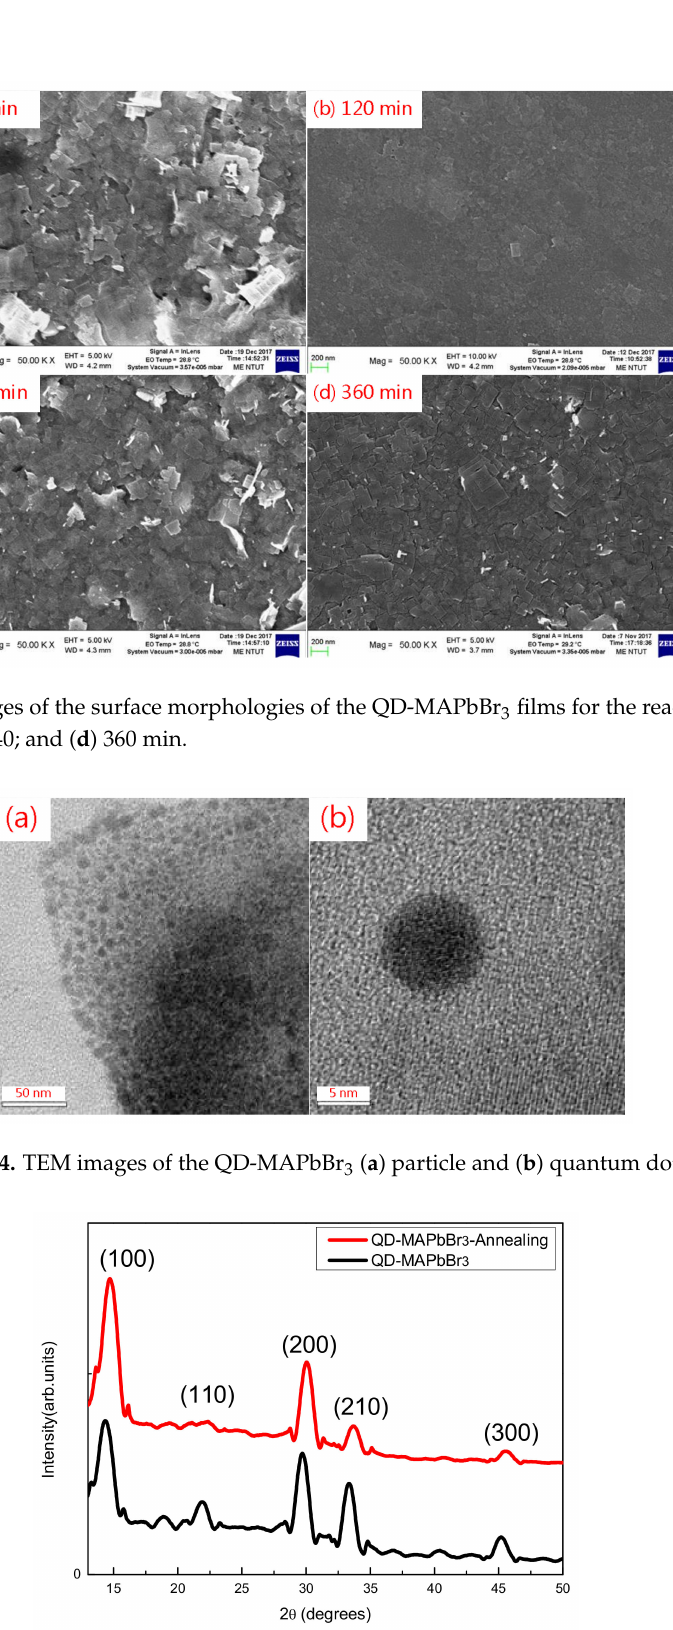
Figure 5. XRD patterns of the QD-MAPbBr 3 with and without annealing